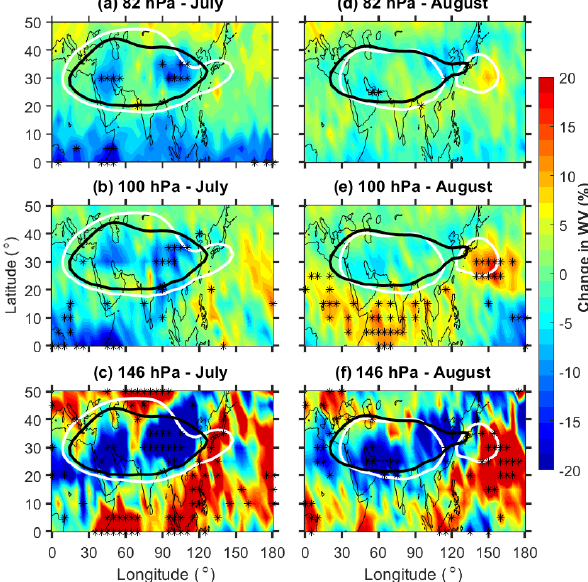
Figure 9. Water vapor relative percentage change in July 2015 with respect to background climatological monthly mean observed at (a) 82hPa, (b) 100hPa, and (c) 146hPa. Subplots of (d) – (f) same as (a) – (c) but for the month of August. The white (black) color con- tour represents the 16.75km geopotential height at 100hPa for the corresponding month in 2015 (mean of 2005–2014). The star sym- bols (black) shown in the figure represent the anomalies greater than the ± 2 σ standard deviation of the long-term mean. The results are obtained from MLS